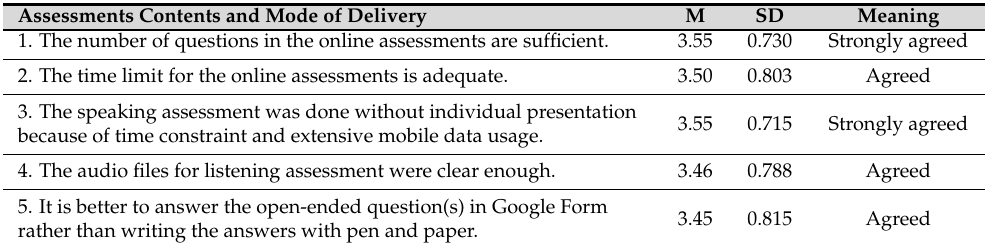
Table 3. Normality of distribution for both groups’ pre-test